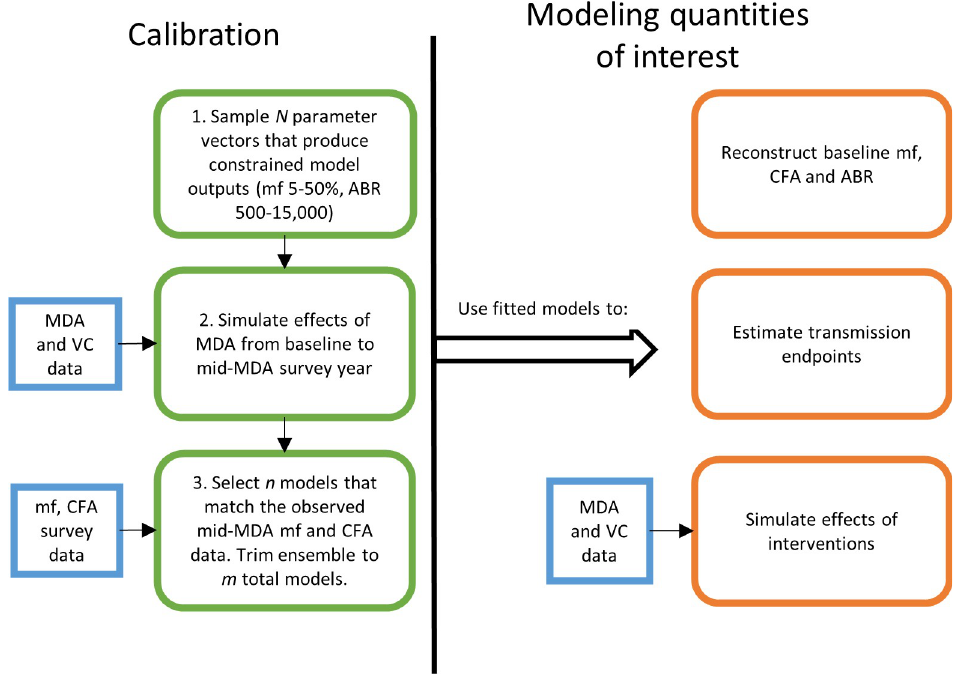
Fig 1. Computational system for discovering local infection data and transmission models. Green boxes represent model calibration steps, orange boxes represent the quantities of interest calculated by the fitted model, and blue boxes indicate the site-specific data needed for the indicated